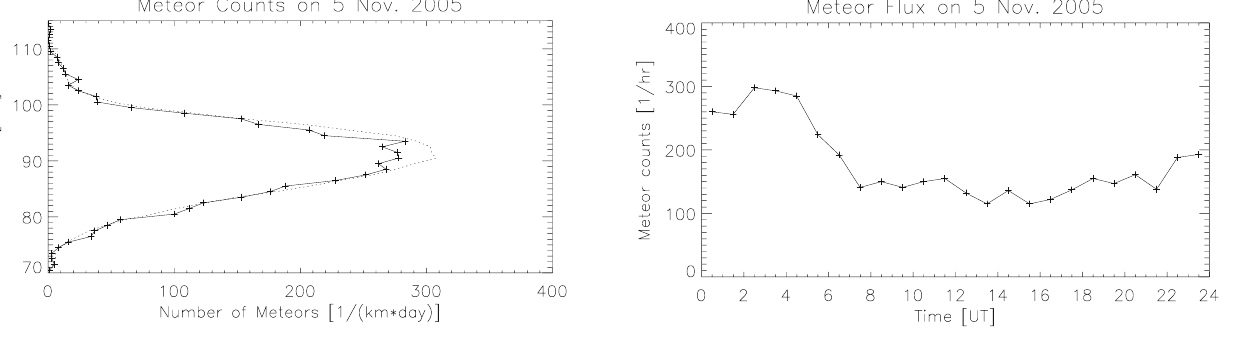
Fig. 4. Diurnal variation of meteor counts on 5 November 2005 measured over Andøya by the SKiYMET meteor